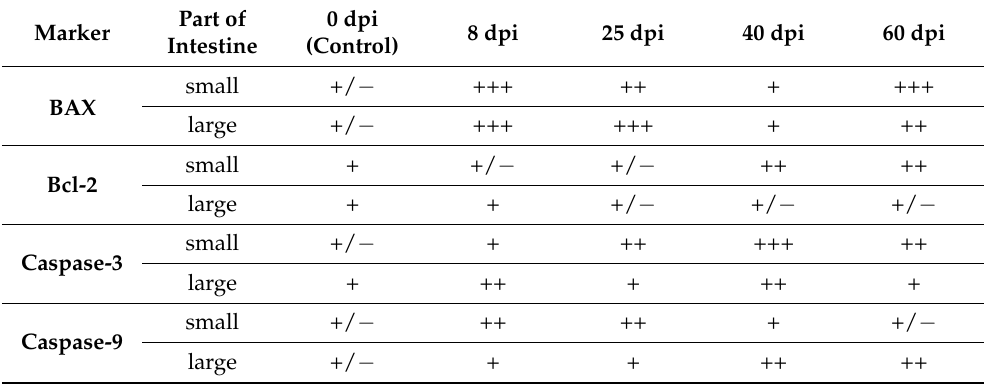
Table 2. Summary of the expression of Bax, Bcl-2, caspase-3, and caspase-9 in the control (0 dpi) and infected animals (8 dpi, 25 dpi, 40 dpi, 60 dpi) presented as intensity of immunostaining. Intensity of immunostaining scored as negative ( − ), very weakly positive (+/ − ), weakly positive (+), moderately positive (++), or strongly positive